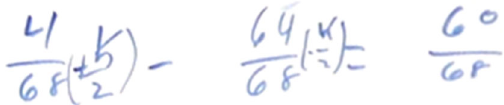
FIG. 3. Raife ’ s use of the summation method for h S y i where he uses probabilities for spin in the z direction. He includes the eigenvalues to label probabilities but states they do not belong in the